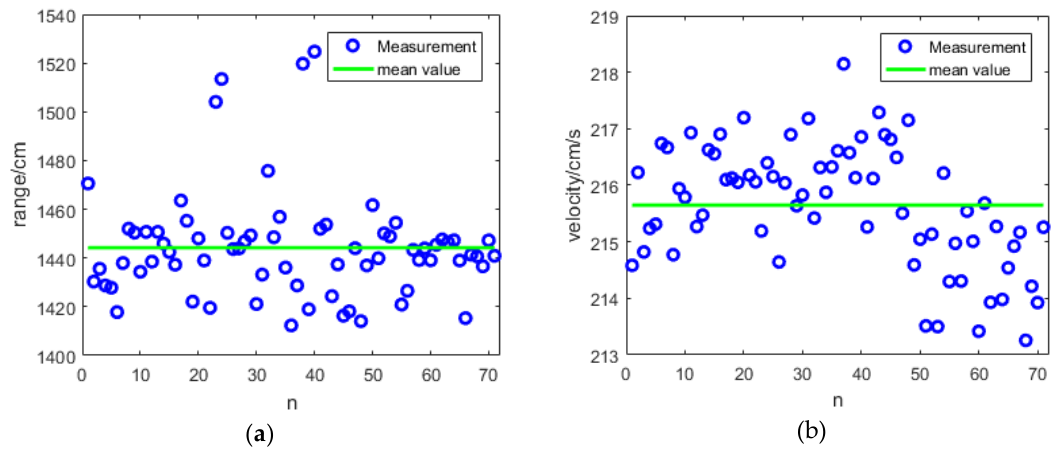
Figure 6 . ( a ) The distance measurements; ( b ) The velocity measurements. Figure 6. ( a ) The distance measurements; ( b ) The velocity measurements.